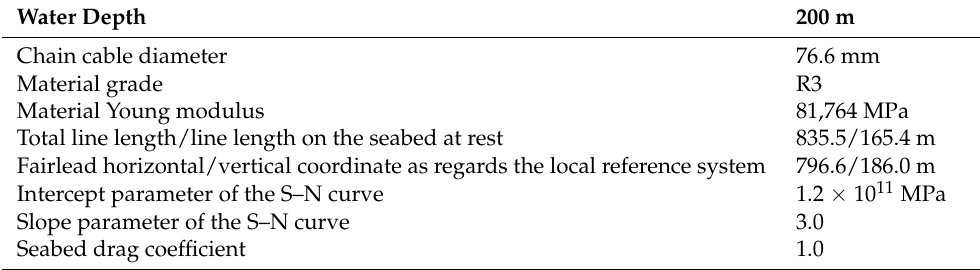
Table 2. Main properties of the reference stationkeeping system.